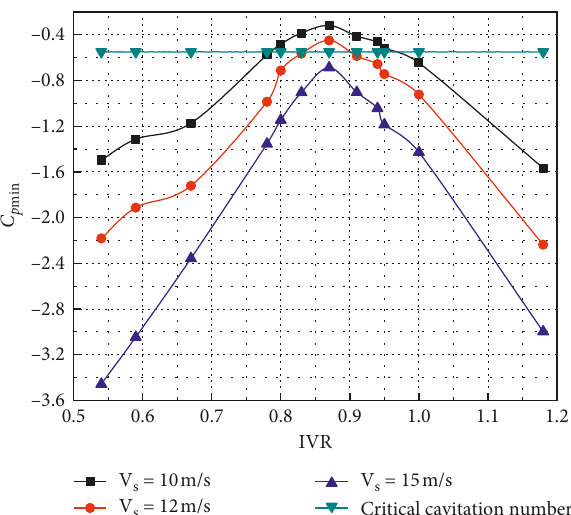
Figure 17: Minimum cavitation number C